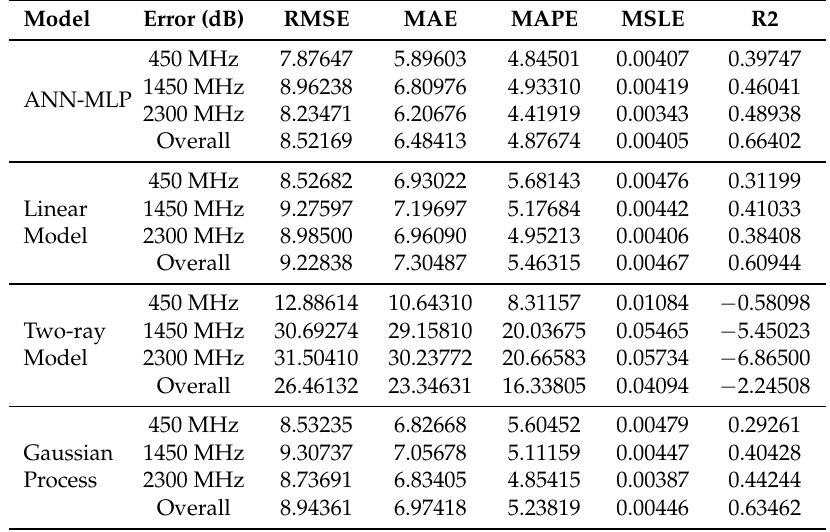
Table 3. Comparison of prediction accuracy of different metrics for Gaussian process